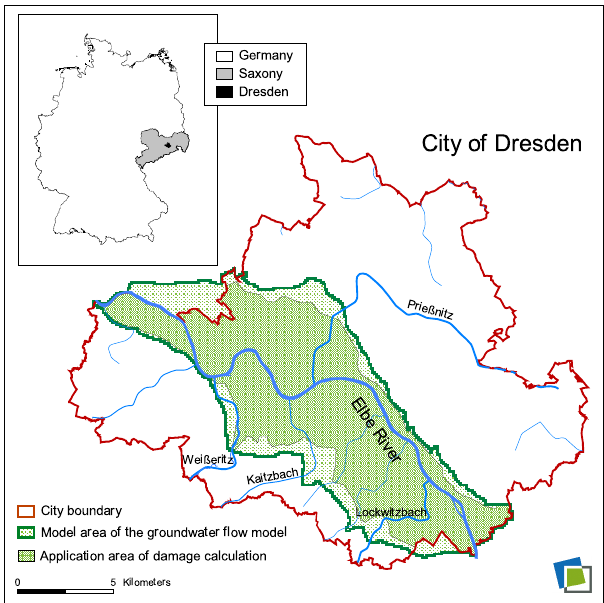
Fig. 6. Location of the study area Dresden with the Elbe River val- ley and its inner-city tributaries as well as the model area of the groundwater flow model (GWFM) and the application area of dam- age calculation; data source: ATKIS® VG250 (Administrative Bor- ders Germany) ©Bundesamt f¨ur Kartographie und Geod¨asie 2009 (Federal Agency for Cartography and